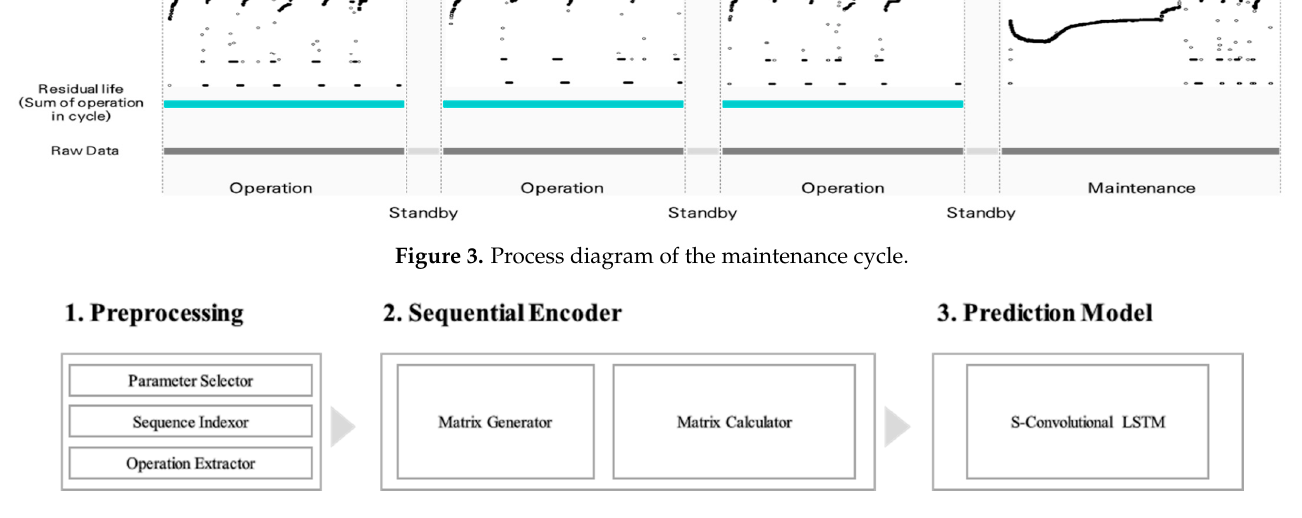
Figure 4. Overall flow of proposed idea.